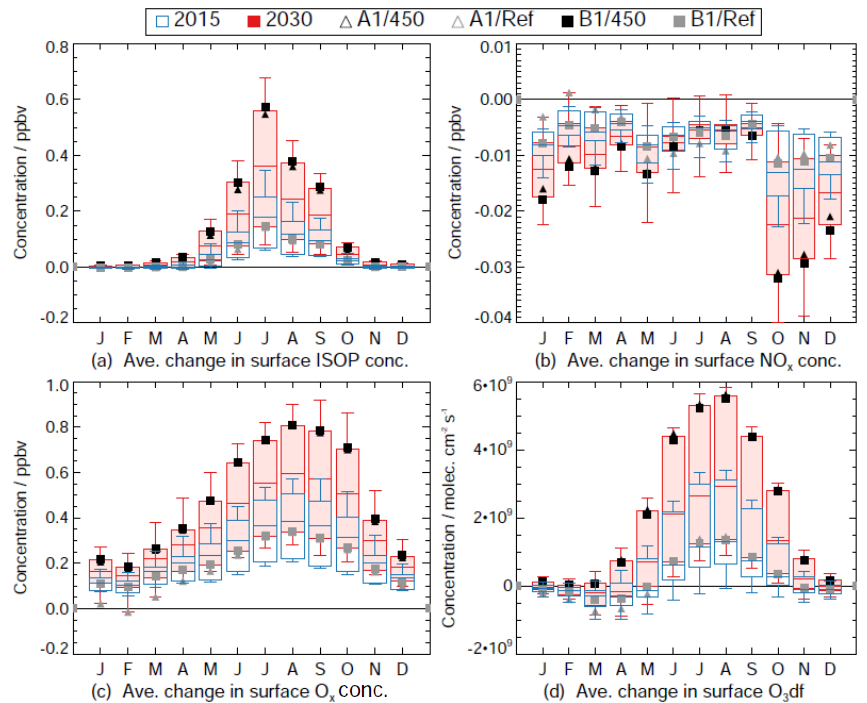
Fig. 13. Same as Fig. 7 but for temperate North America (Fig. 6).